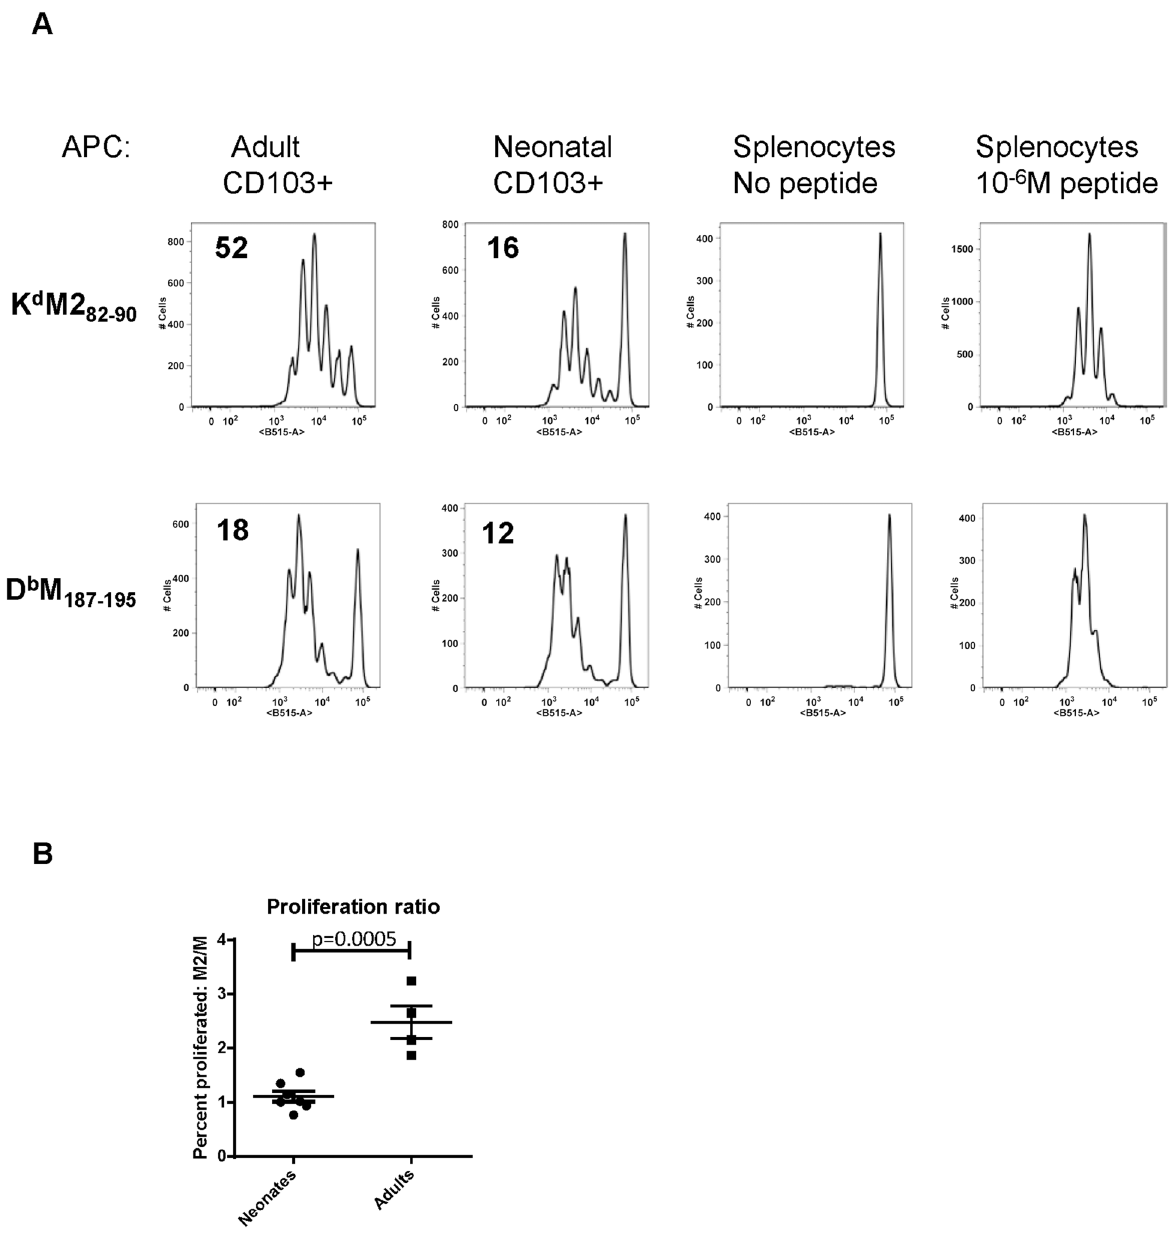
Figure 5. Neonatal CD103 + DCs differentially induce RSV-specific adaptive CD8 + T cell responses. A) CFSE-labeled TCR transgenic CD8 + T cells specific for K d M2 82–90 or D b M 187–195 were co-cultured in a 10:1 ratio with CD103 + dendritic cells sorted from the lymph nodes of RSV infected adults or neonates one day after infection. The percent of cells that proliferated following three days in co-culture was calculated using the proliferation module in FlowJo 9.4.10. Negative control samples consisted of TCR Tg T cells co-cultured with splenocytes with no exogenous peptide, and positive control samples were co-cultured with splenocytes and 10 2 6 M of specific peptide. B) Comparison of the ratio of proliferation (percent of K d M2 82–90 -specific cells that proliferated/percent of D b M 187–195 -specific cells that proliferated) induced by flow-sorted neonatal vs. adult CD103 + DCs. Groups were compared using a student’s